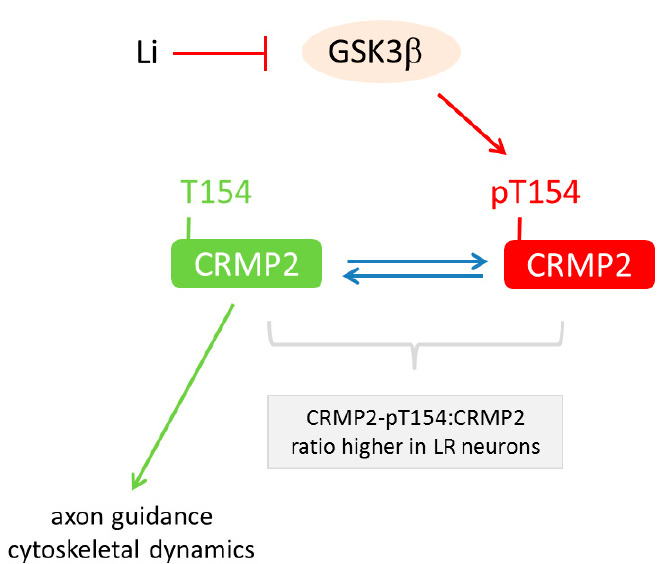
Figure 2. Model of the lithium-response pathway in bipolar disease. CRMP2 (collapsin response mediator protein-2) is a major target of GSK3 β (glycogen synthase kinase). This enzyme catalyzes phosphorylation of the threonine (T) residue 154 in CRMP2. This step associates with CRMP2 inactivation in human neuronal progenitor cells and mature neurons. Conversely, inhibition of GSK3 β by lithium prevents CRMP2 inactivation and supports its role in axon guidance and cytoskeletal dynamics. Interestingly, the ratio of CRMP2-pT154:CRMP2 is higher in neurons from lithium responsive (LR) patients and is normalized under lithium (Li) treatment.